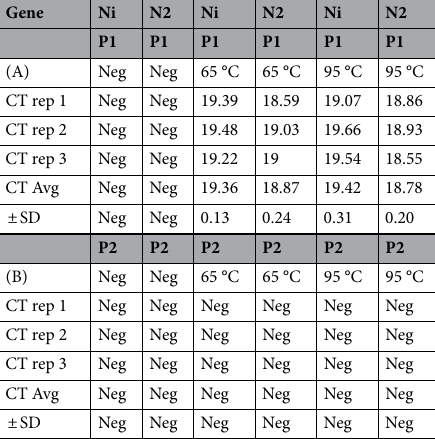
Table 1. Direct amplification of SARS-CoV-2 in vLAB. (A) Pass1 (P1): Ct values from direct RT-PCR amplification using as template 2 µL of lysates of SARS-CoV-2 virus in vLAB (diluted 1:10). The samples were incubated at room temperature (RT) for 10 (light green) and 20 min (dark green) and then were tested by RT-PCR. Neg = non detected, only MEM culture media. (B) Pass 2 (P2): CT values from direct RT-PCR amplification using as template 2 µL of supernatants from P1, samples were incubated as described previously. Neg = Non detected, Rep = repetition, CT = cycle thresholds, N1 and N2 = nucleocapsid gene 1 and 2. vLAB = virus Lysis Amplification